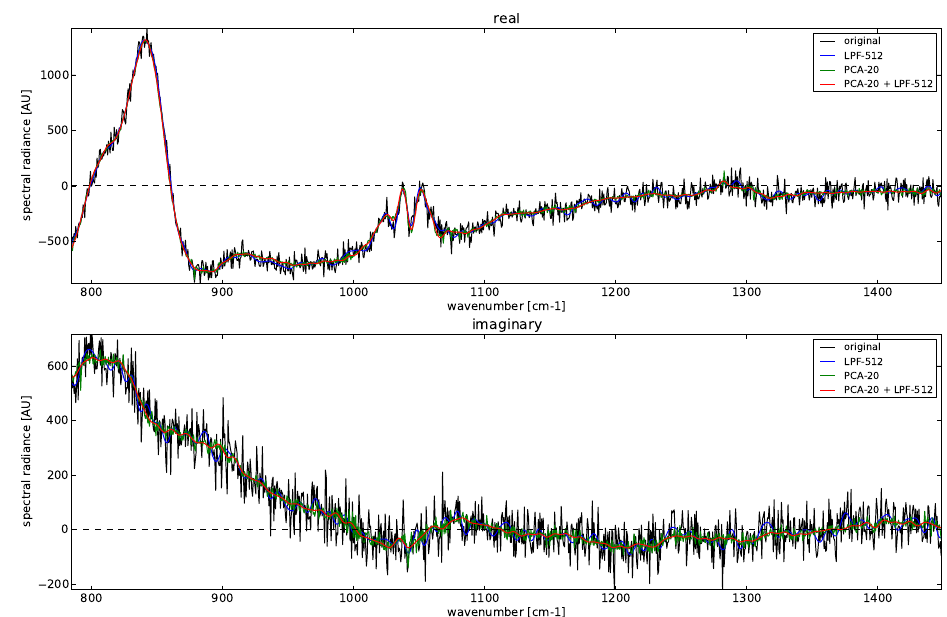
Figure 12. Comparison between the PCA, low-pass and combined noise suppression methods, applied to the same DS measurement as in Fig. 6.